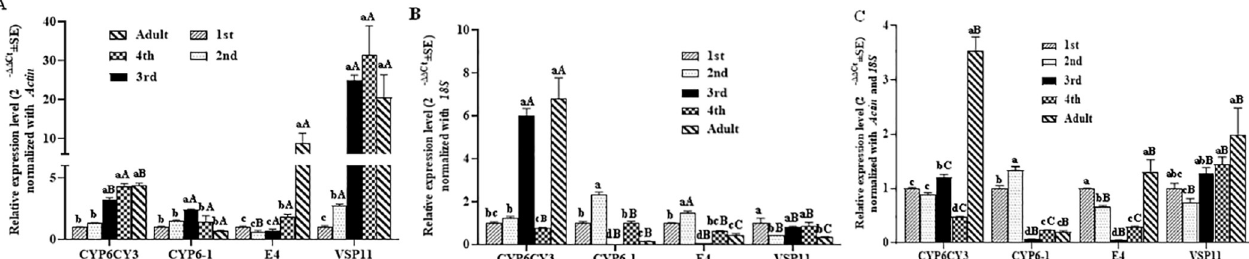
Fig 4. Expression of target genes at different developmental stages of M . persicae normalized to Actin (A) and 18S (B) alone and in combination (C). Values are shown as the mean ± SEM. Bars with different letters are significantly different from each other ( P < 0.05). Lowercase letters indicate the comparison among different developmental stages for one target gene normalized with the same housekeeping gene. Uppercase letters represent the comparison among different normalized genes for one target gene under the same developmental stage.